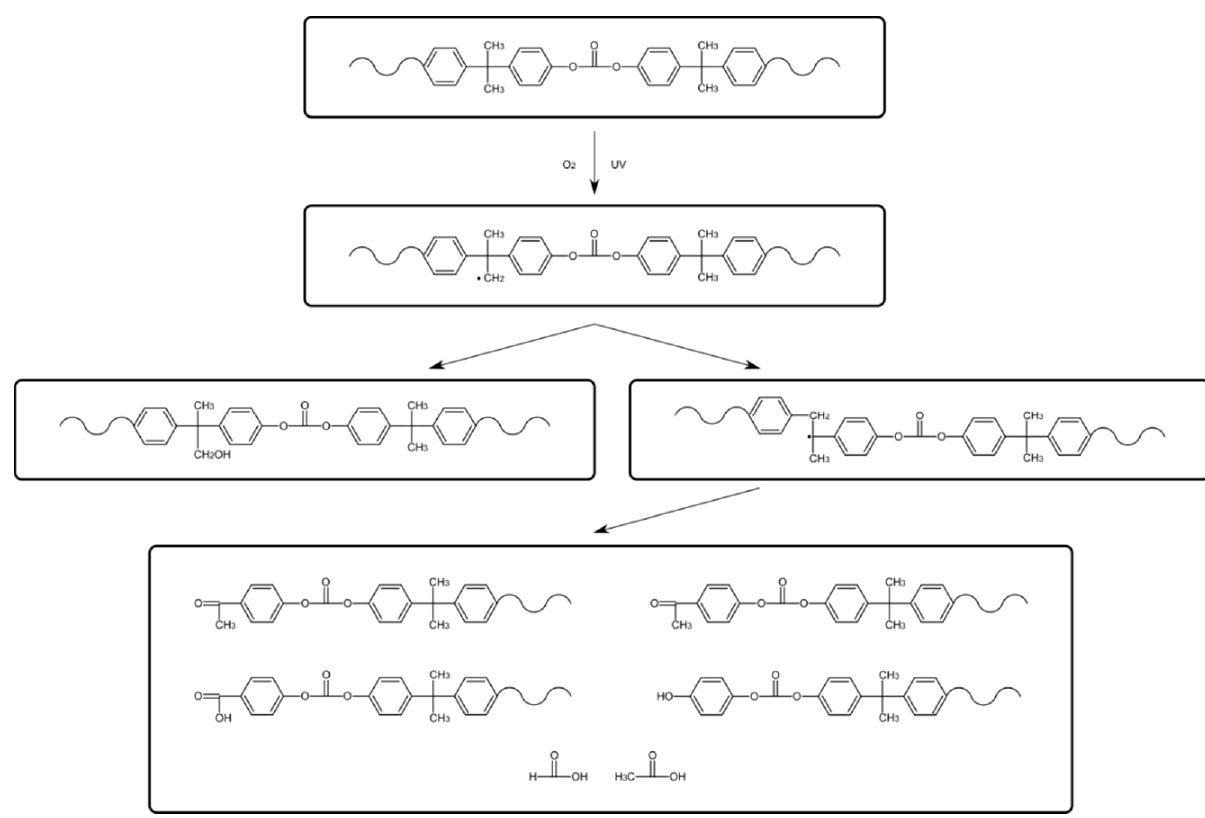
Figure 1. Photo-oxidative degradation of polycarbonate.